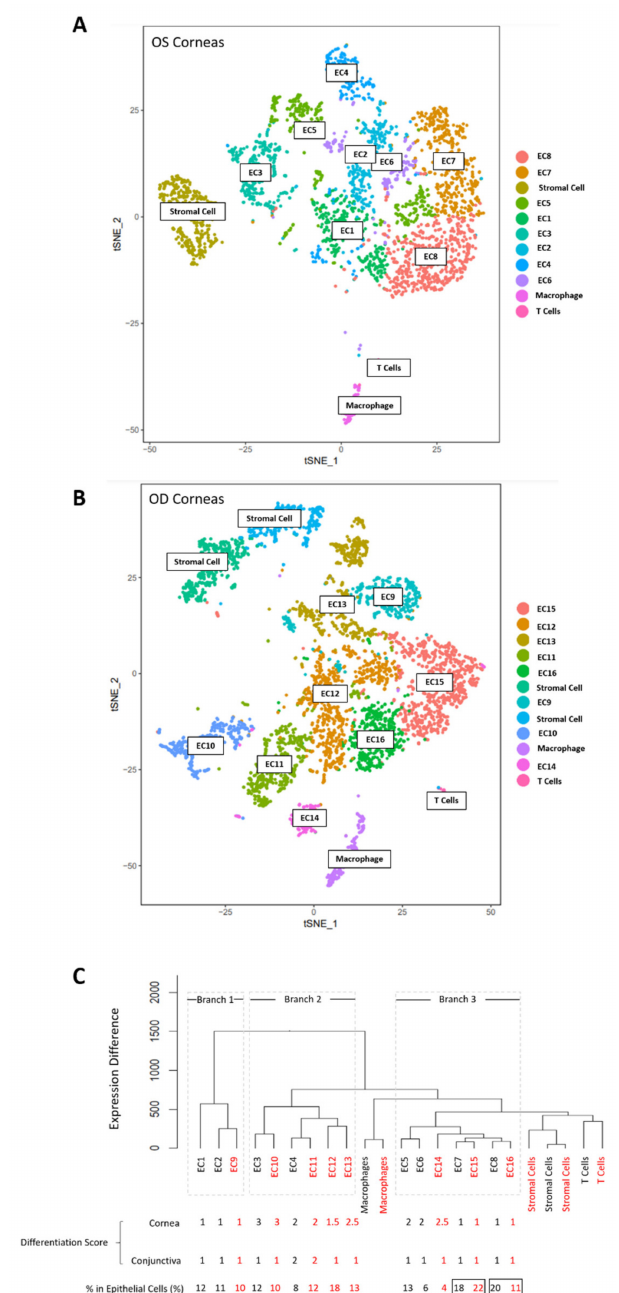
Figure 5. The heterogeneous cell populations at limbus revealed by single-cell RNA sequencing under normal homeostasis and upon wounding. ( A ) tSNE plot of the corneas under normal homeostasis. ( B ) tSNE plot of the corneas upon wounding. ( C ) Differentiation trajectory of the cell clusters from unwounded and wounded corneas. There were 3 branches of epithelial clusters in the dendrogram, designated as “Branch 1”, “Branch 2”, and “Branch 3”, respectively. EC: epithelial cluster. Differenti- ation score for cornea was based on the natural segregation of Krt12 expression: 1: <0.9, 2: 5.5–20, and 3: >180. Differentiation score for conjunctiva was based on the natural segregation of Krt13 expression: 1: <0.8 and 2: >9. The cell number of each EC during normal homeostasis and upon wounding were presented as the percentage of cell number in total epithelial cells (non-epithelial cells were not included). Black font indicates data of clusters under normal homeostasis. Red font indicates data of clusters upon